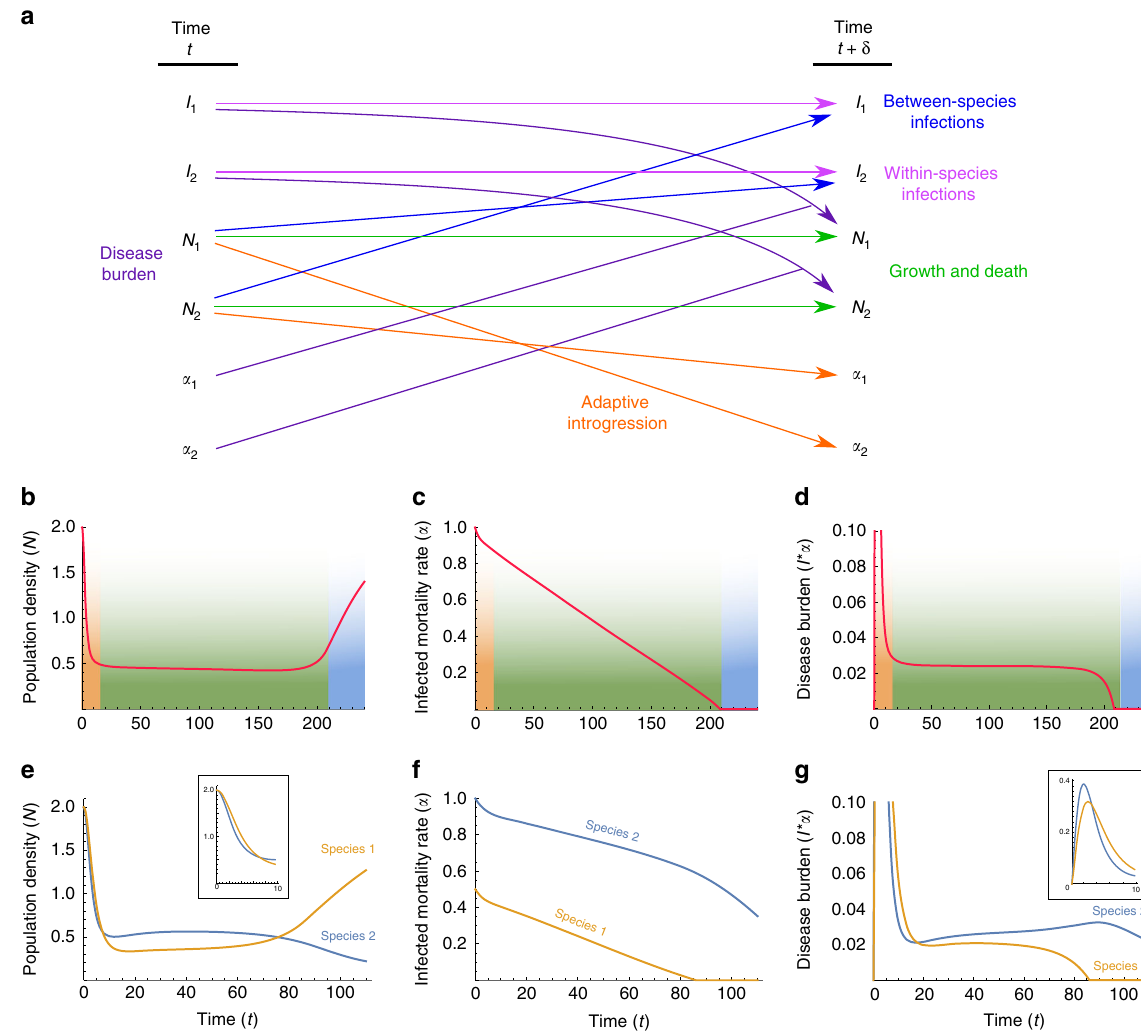
Fig. 5 Alternative single-time-scale model of disease-introgression dynamics. a Schematic description of the model. The dynamics of the model are described by Eqs. (16) – (22). In this model, the population densities N i ð t Þ are modeled, with disease burden caused by disease-induced mortality α i ð t Þ of infected individuals I i ð t Þ . Adaptive introgression reduces disease-induced mortality over time. ( b – d ) show the dynamics with symmetric initial conditions, comparable to Fig. 3, and ( e – g ) show results with asymmetric initial conditions, comparable to Fig. 4. ( b ) and ( e ) show population densities, N i ð t Þ (Eqs. (17) and (18)). ( c ) and ( f ) show the added mortality rate due to infection from novel pathogens, α i ð t Þ (Eqs. (21) and (22)). ( d ) and ( g ) show disease burden, measured as I i ð t Þ ´ α i ð t Þ (Eqs. (19) – (22)). The parameters for the scenario modeled are λ ¼ 0 : 15 ; K ¼ 1 ; β